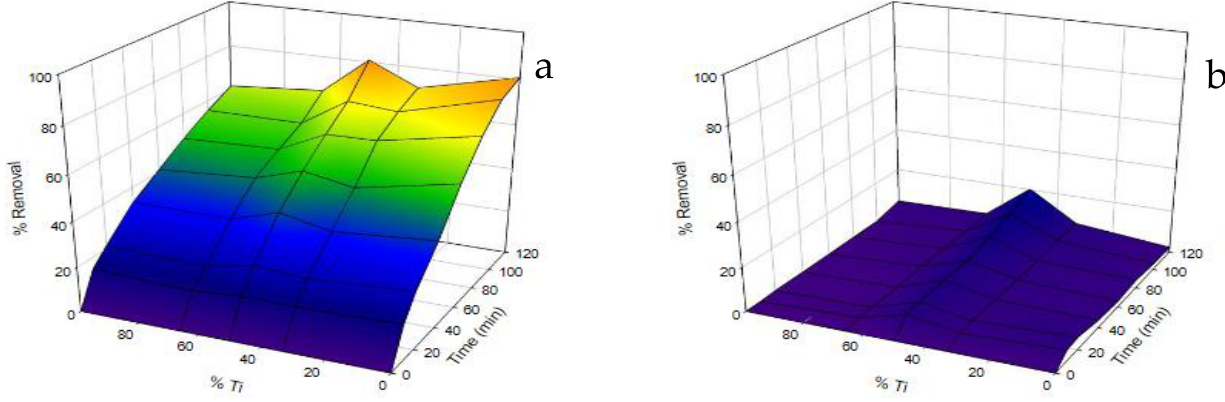
Figure 8. Three-dimensional curves of removal of 200 ppm ions with 10 ppm dye in the presence and absence of UV irradiation: ( a ) under UV irradiation; ( b ) without UV irradiation. Figure 9. Three-dimensional curves of removal of 400 ppm ions with 10 ppm dye in the presence and absence of UV irradiation: ( a ) under UV irradiation; ( b ) without UV irradiation.